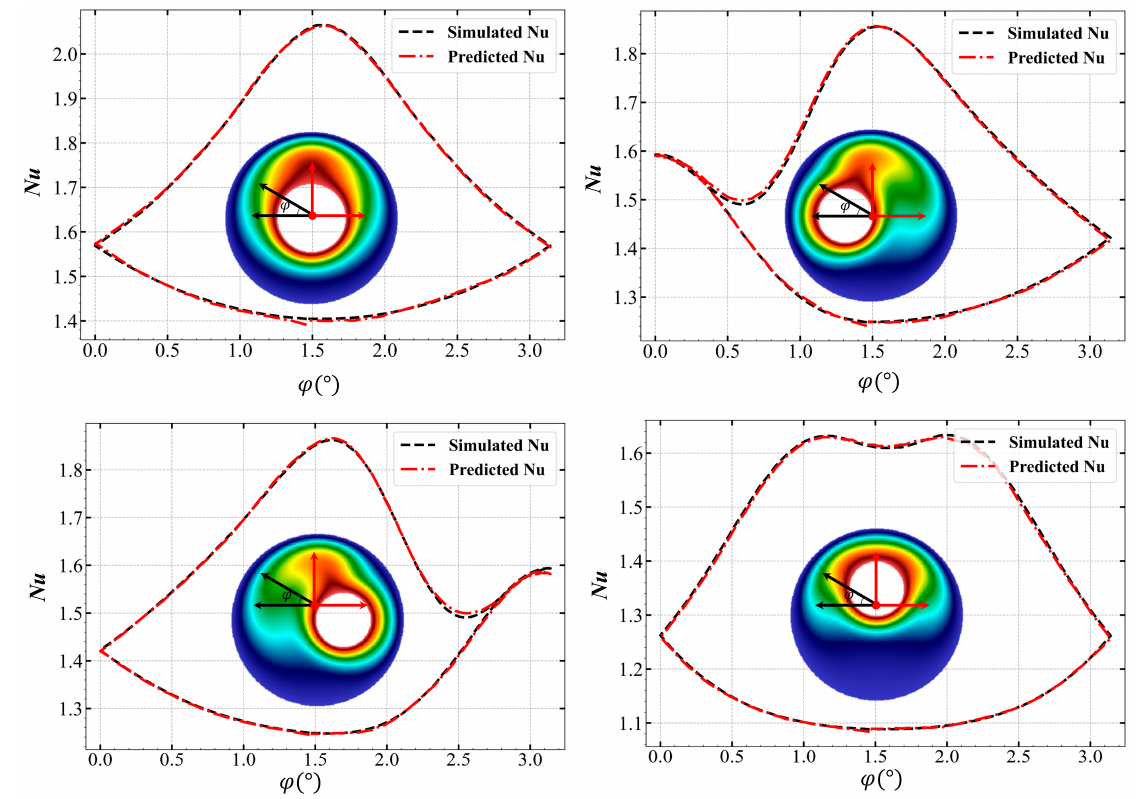
Figure 5. Nusselt number predictions of four representative single inner-cylinder annulus with various inner cylinder diameters and